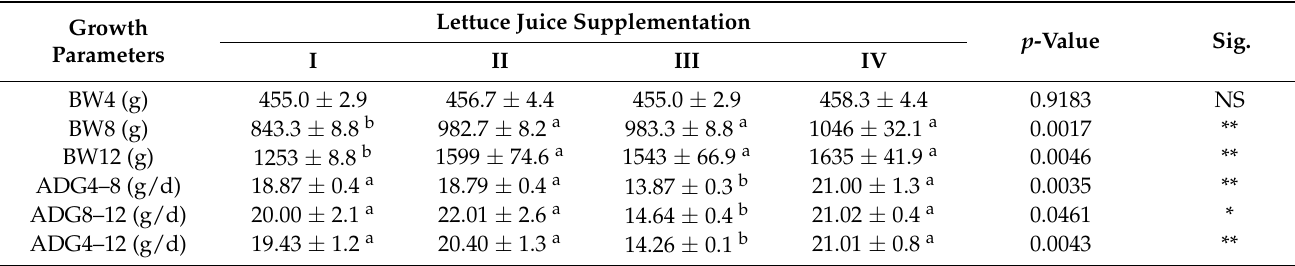
Table 5. Growth performance of weaned V-line rabbits administered lettuce juice fertilized with nitrate vs WPH as compared to that of nonfertilized lettuce or lettuce-free diet. Growth